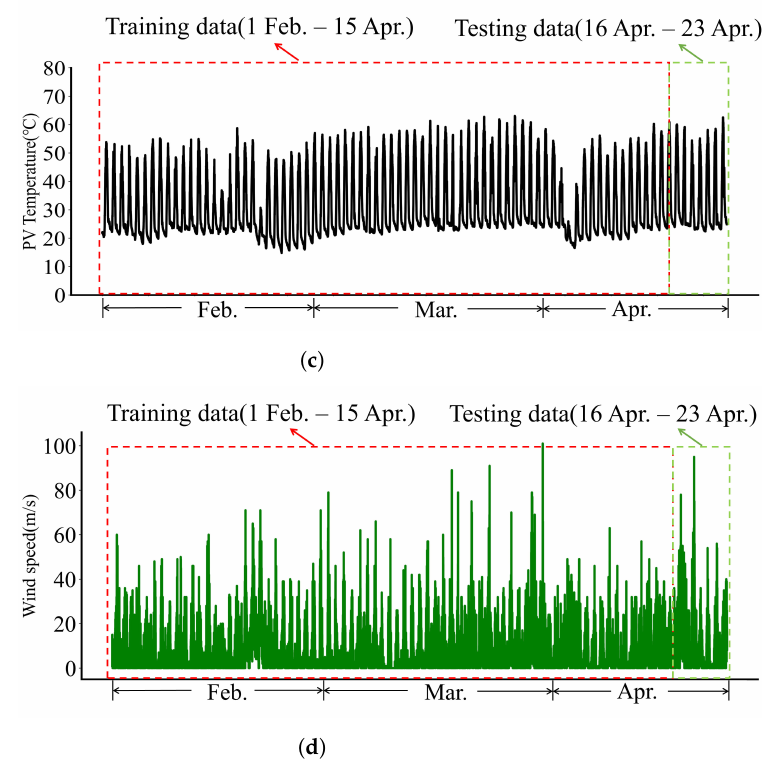
Figure 2. Training and testing dataset. In our work, four types of input data directly affecting PV power generation were used for training and testing the deep learning models; ( a ) PV power generation data; ( b ) solar irradiance data; ( c ) PV module temperature data; ( d ) wind speed